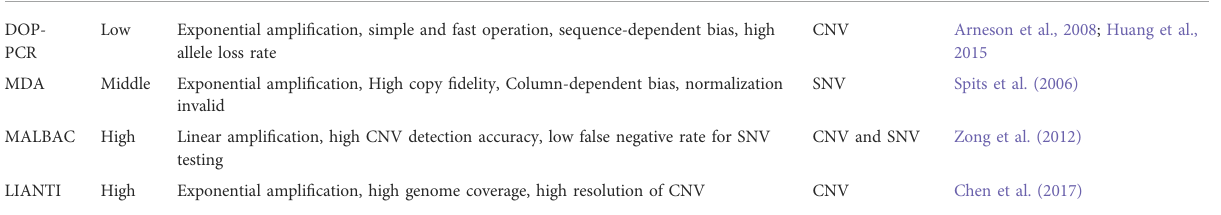
TABLE 3 Comparison of different scDNA-seq technologies. Method Scope Features